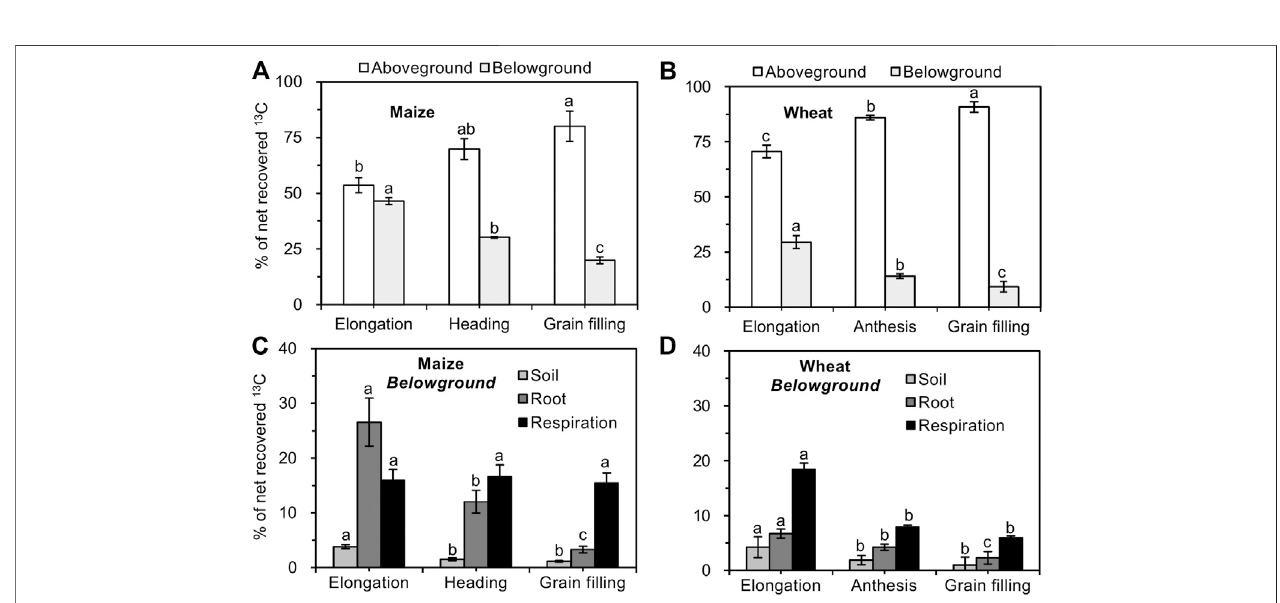
FIGURE 3 | Proportion of net photosynthesized 13 C in each component of the crop – soil system (mean ± SE, n (cid:2) 3 for maize and n (cid:2) 4 for wheat). Note: Different lowercase letters indicate signi fi cant differences between growth stages at the p < 0.05 level.